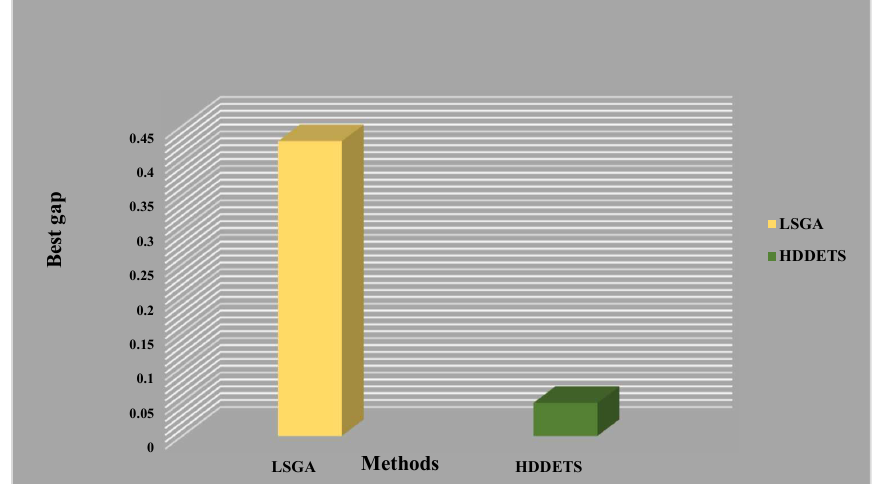
Fig. 12 . Comparison on Average best for